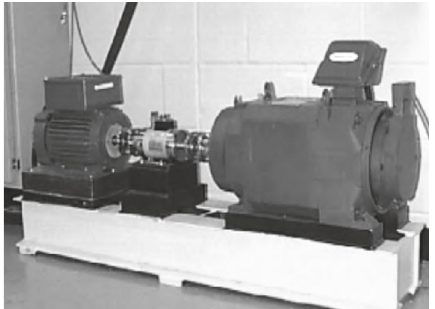
Figure 3: Case Western Reserve University Rolling experiment platform.